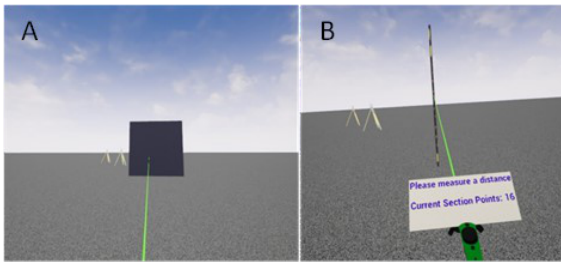
Figure 7. (A) The 3D model of a cube as a test object, (B) A vertical slice of the 3D model of a